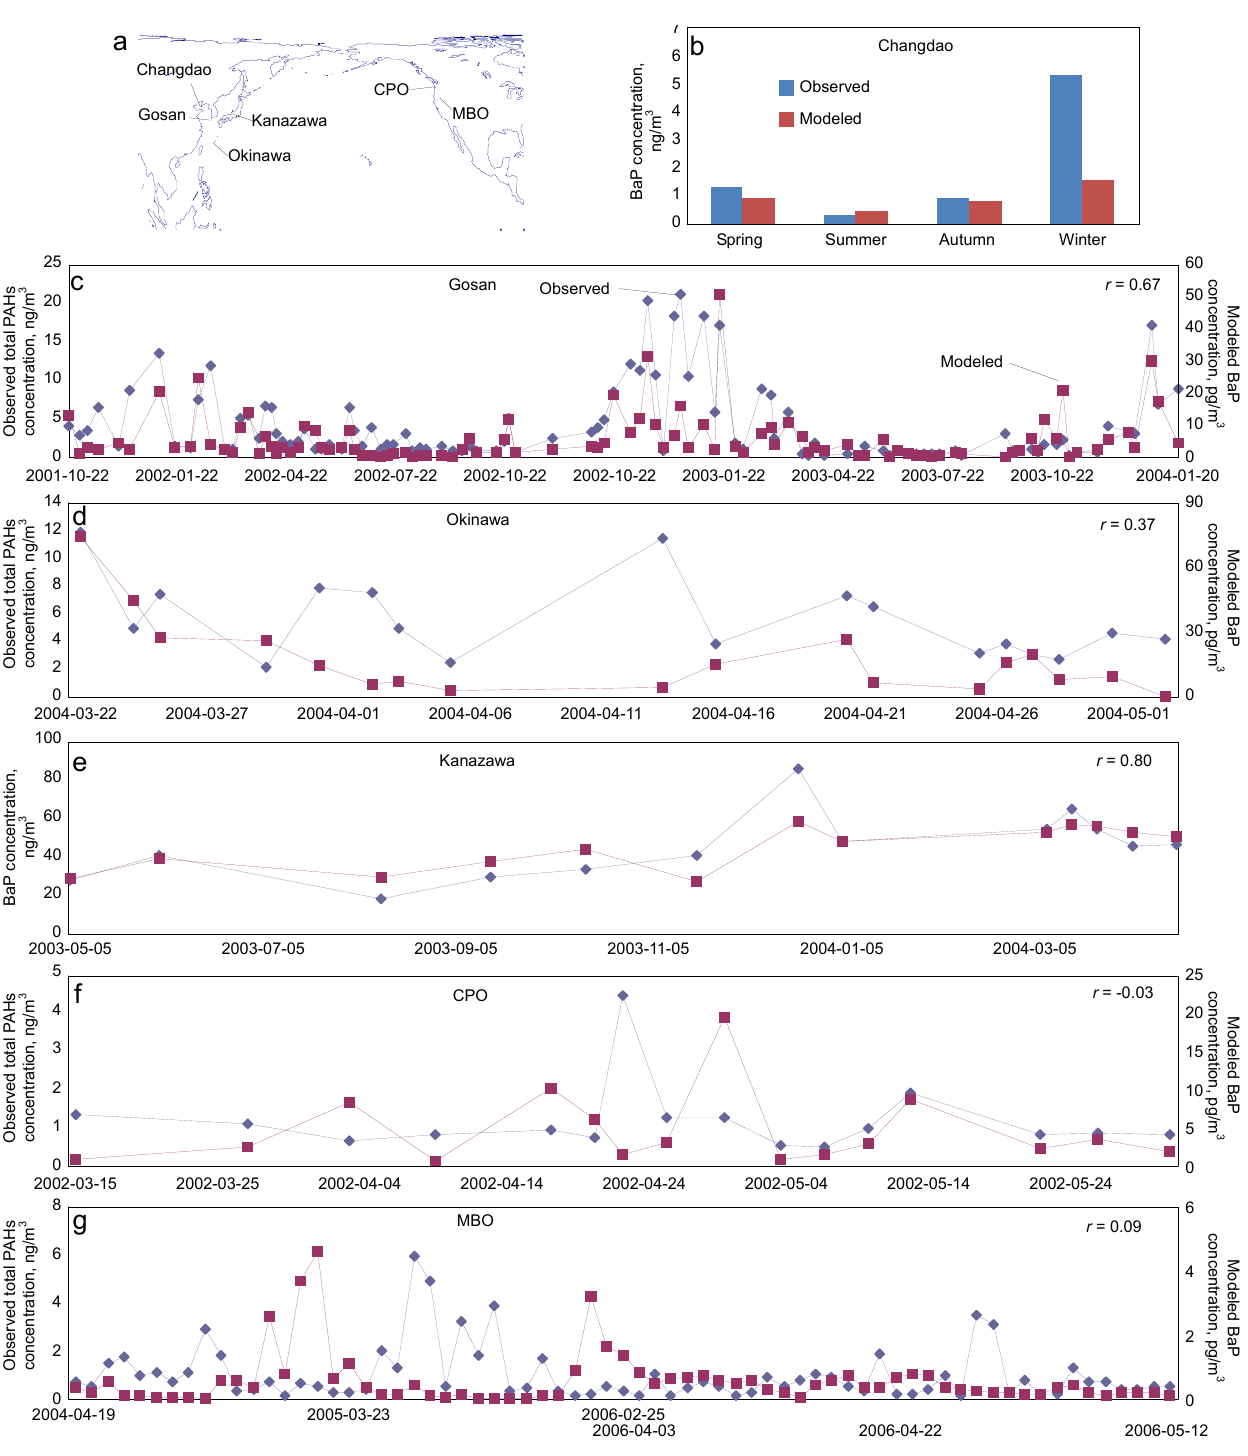
Fig. 1. Comparison of the modeled BaP concentrations with observations at different sites: (a) a map of the locations of these sites; (b) seasonally averaged total BaP concentration at Changdao, China during 2003–2004; (c) comparison of weekly averaged particulate phase total PAH concentration at Gosan, Korea with modeled total BaP concentration during 2001–2004; (d) comparison of total PAH concentration at Okinawa, Japan with modeled total BaP concentration during May, 2004; (e) comparison of total BaP concentration at Kanazawa, Japan with modeled total BaP concentration during 2003–2004; (f) comparison of the total PAH concentration at CPO, US with modeled total BaP concentration during March–May, 2002; (g) comparison of total PAH concentrations over MBO, US with modeled BaP concentration during 2004 ‐ 2006.